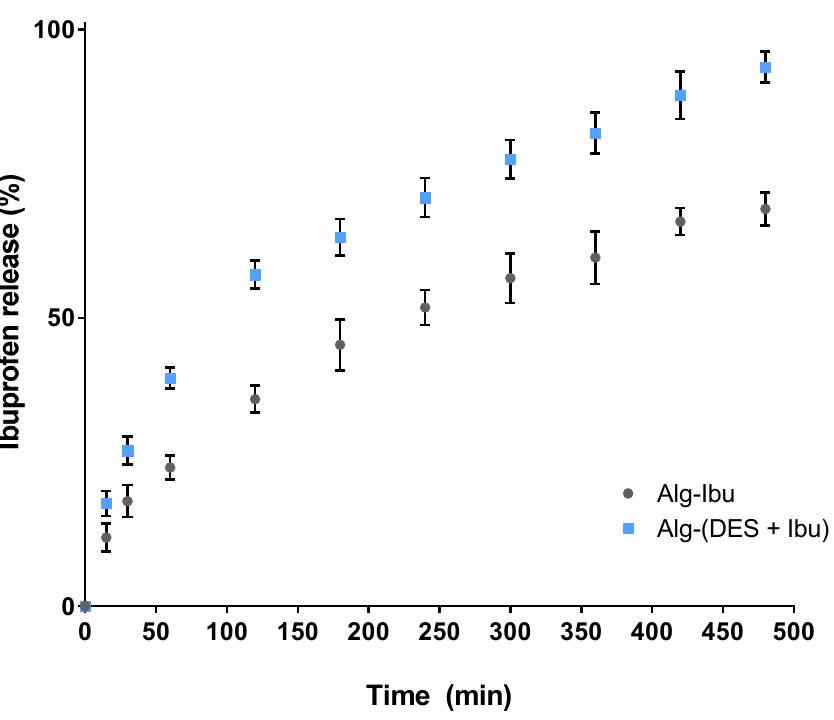
Figure 7. In vitro release profile of ibuprofen from alginate-based hydrogels in PBS solution. Profile data represented as mean ± SD of three independent experiments. Table 1. The average cumulative mass of ibuprofen after 6 h permeation from the hydrogel with ibuprofen and the hydrogel with ibuprofen solubilized in the DES aqueous solution test across human